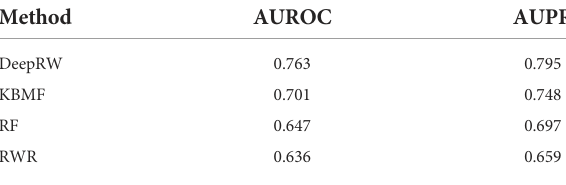
TABLE 2 The AUROC and AUPR scores of different